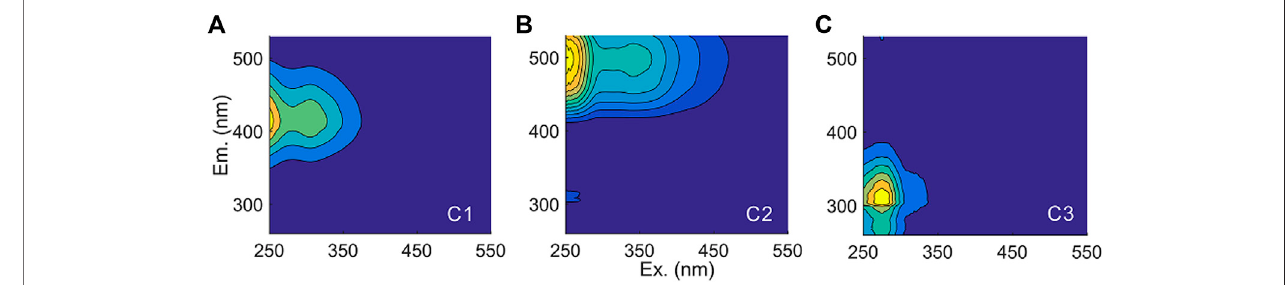
FIGURE 2 | Fluorescence spectra of three PARAFAC components identi fi ed in this